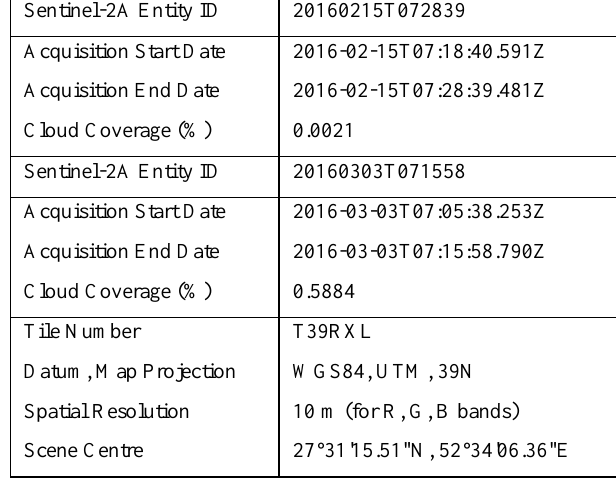
Table 1. The detailed information of two Sentinel-2A